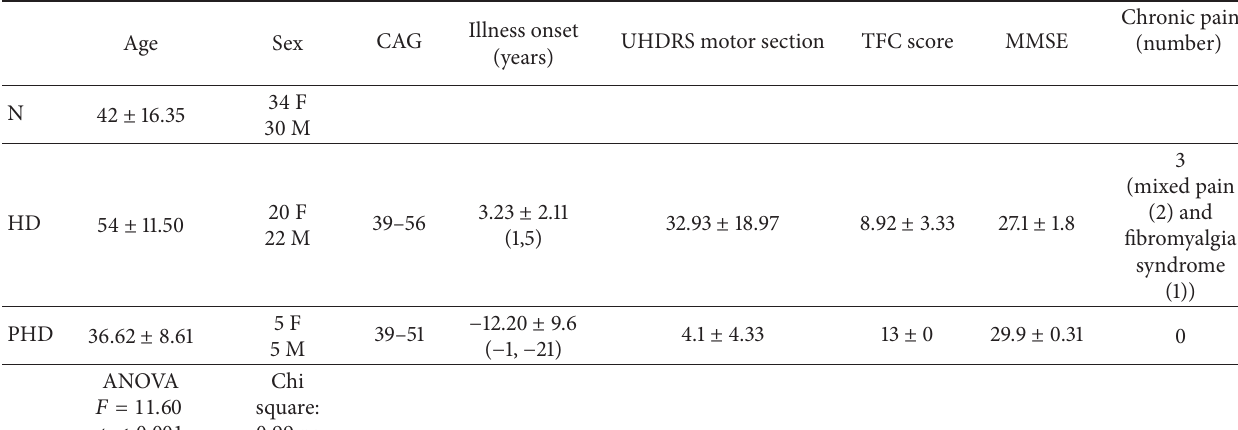
Table1:Demographicandclinicaldatainnormalsubjects(N),Huntington’sdisease(HD)patients,andpresymptomaticHuntington’sdisease (PHD) patients. The ANOVA analysis shows that age was different among groups. TFC score: total functional capacity score; UHDRS: Unified Huntington’s Disease Rating Scale; MMSE: Mini-Mental State Examination. The CAG range is reported. For time from or before illness onset, the range is reported in parentheses. In PHD, negative values indicate the supposed years before clinical HD